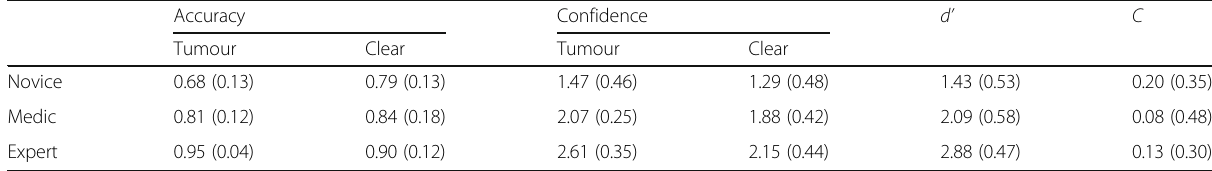
Table 2 Mean and standard deviations (in parentheses) for performance measures in Experiment 1B Accuracy